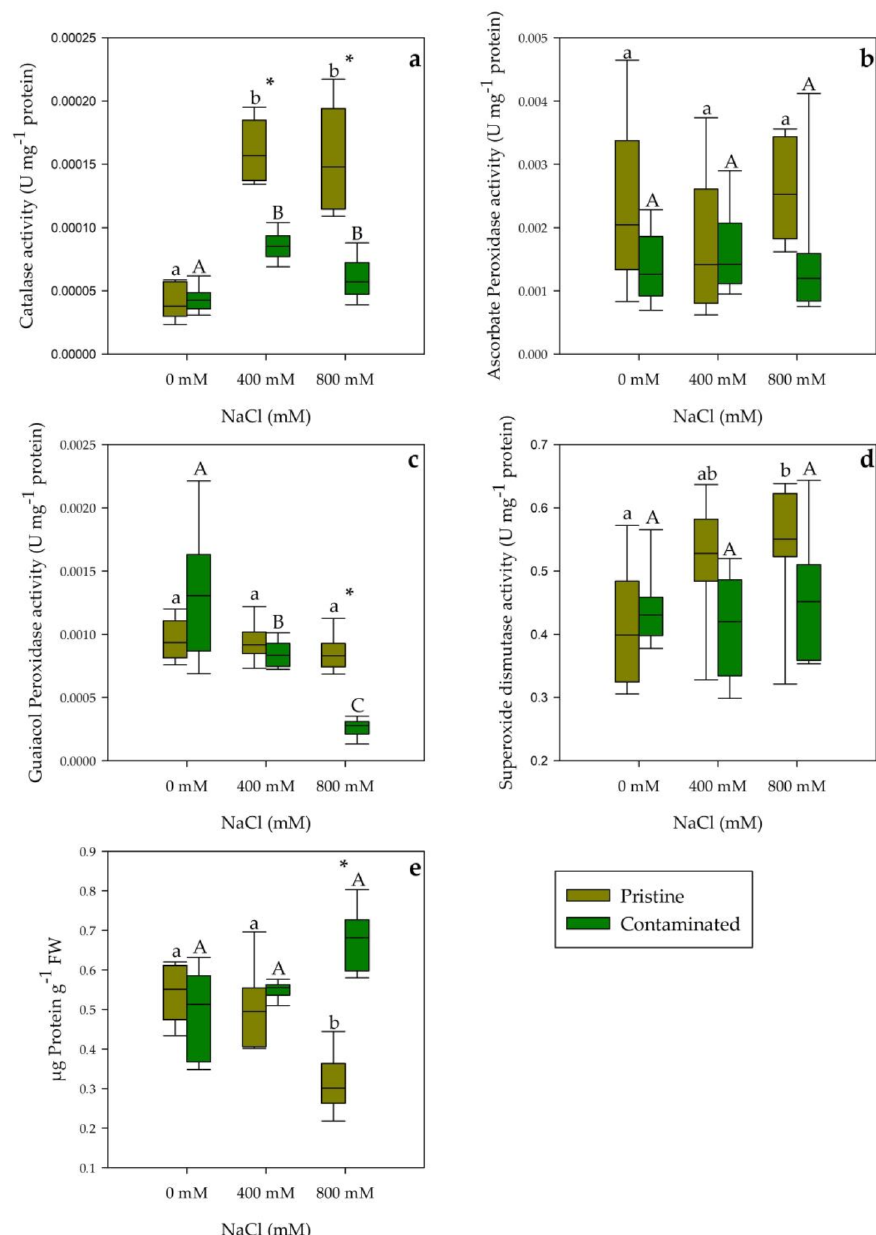
Figure 6. ( a ) Catalase, ( b ) ascorbate peroxidase, ( c ) guaiacol peroxidase, and ( d ) superoxide dismutase activities (U mg − 1 protein) and ( e ) total protein content ( µ g Protein g − 1 FW) in the leaves of S. patens from pristine and heavy metal contaminated sites (average ± standard error, N = 5), along with the tested NaCl concentrations. Letters indicate significant differences between treatments at p < 0.05; asterisks mark significant differences between populations at p <